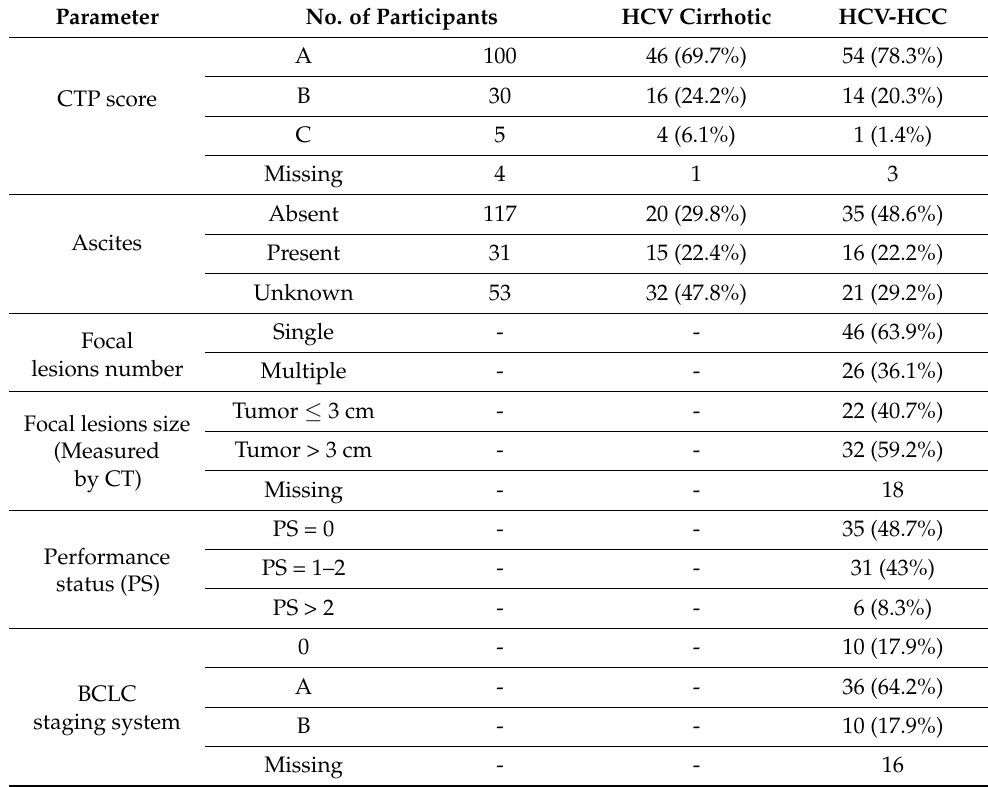
Table 3. Characteristics and staging of HCC